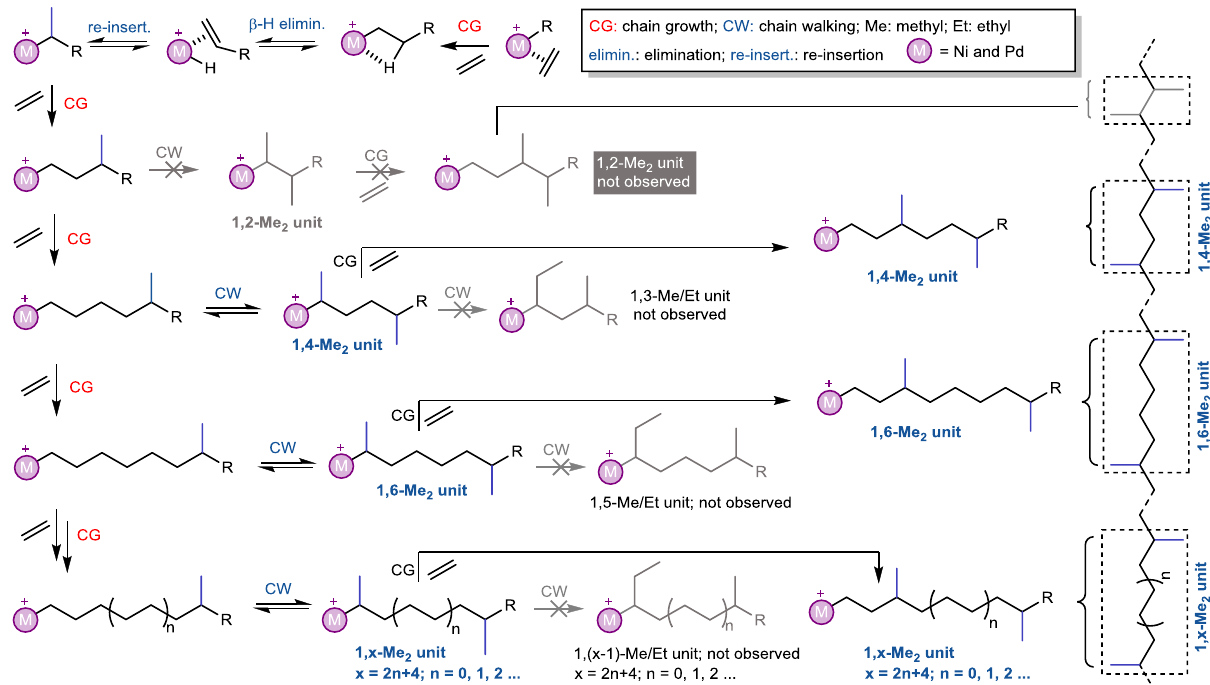
Fig. 4 Proposed mechanism for the formation of branch. Possible branch pattern and distribution formed by chain walking in ethylene polymerization.